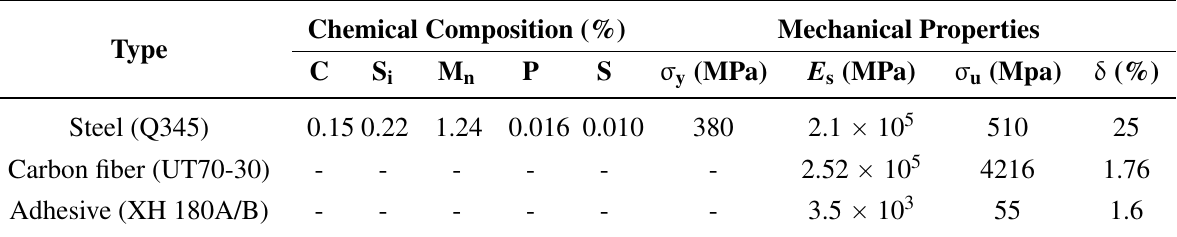
Table 1. Chemical composition and mechanical properties of steel, carbon fiber and